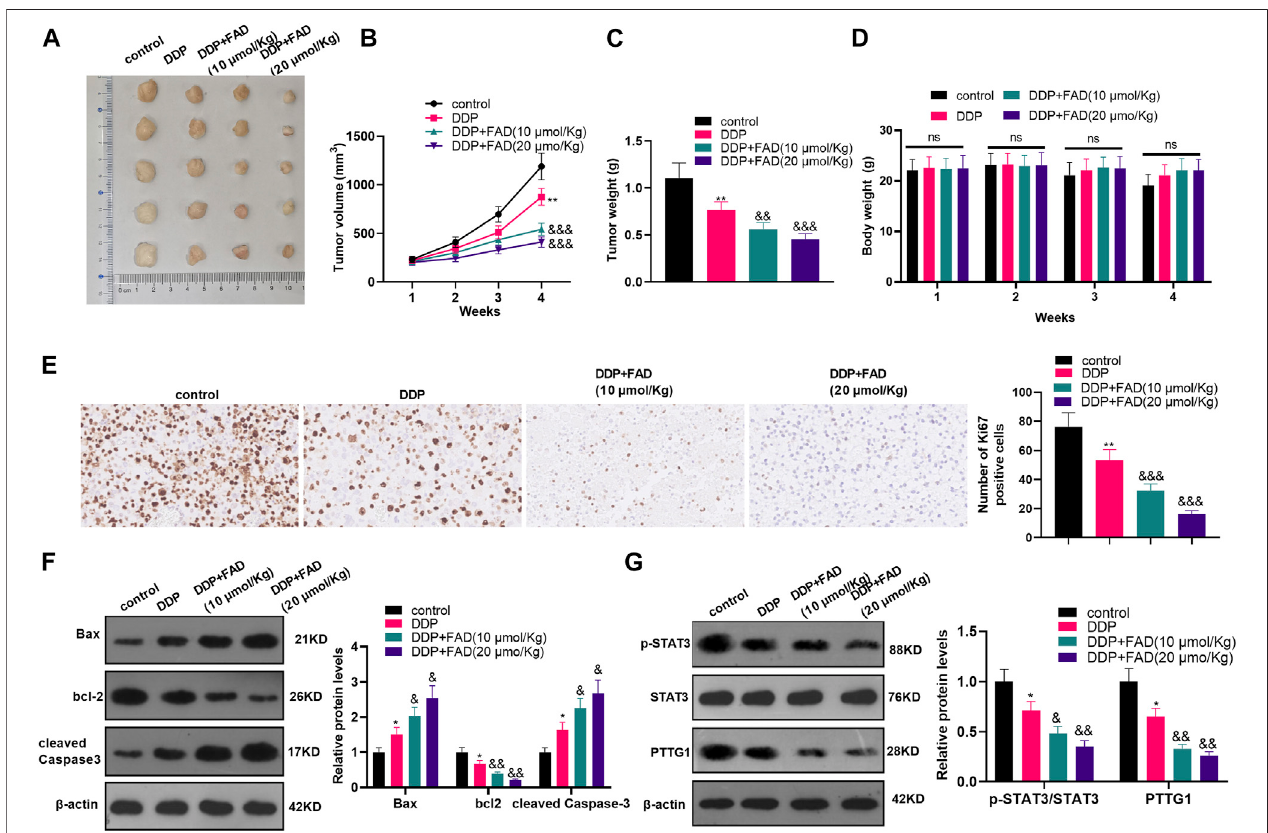
FIGURE 7 | FAD promoted the chemosensitivity of HCC to DDP in nude mice. The nude mice were randomly divided into four groups. The mice were intraperitoneally injected with cisplatin (2 mg/kg) every 4 days for 28 days and/or FAD (10 – 20 mmol/kg) every other day for 28 days. On the 28th day, the nude mice were sacri fi ced and the tumor tissues were isolated. (A) . Tumor images were shown. (B, C) . The volume and weight of the mice removed tumors were calculated. (D) . The bodyweight of the nude mice was calculated. (E) . IHC was utilized to analyze the number of Ki67 positive cells. (F, G) . The expression of apoptosis-related proteins and STAT3/PTTG1 were compared by WB. * p < 0.05, ** p < 0.01 (vs. DDP group). & p < 0.05, && p < 0.01, &&& p < 0.001 (vs. DDP + FAD group). N (cid:2)